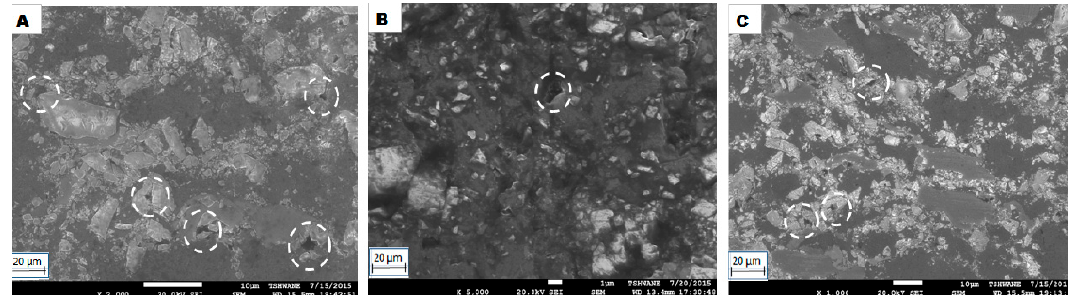
Figure 4. Scanning electron micrograph of the coatings: ( A ) 450 °C; ( B ) 500 °C; ( C ) 550 °C.